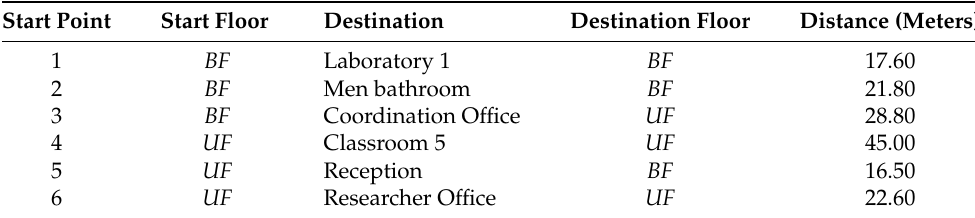
Figure 5. Scenario and navigation tasks for the University building. Table 2. University building navigation tasks: BF denotes Bottom Floor, and UF denotes Upper